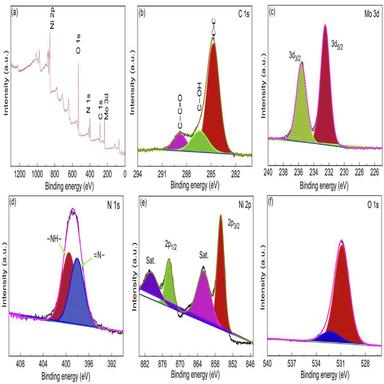
(Color online) Representative XPS survey spectrum of NiO@NiMoO4@PPy sample (a) and XPS core level spectrum of C 1s (b), Mo 3d (c), N 1s (d), Ni 2p (e) and O 1s (f).